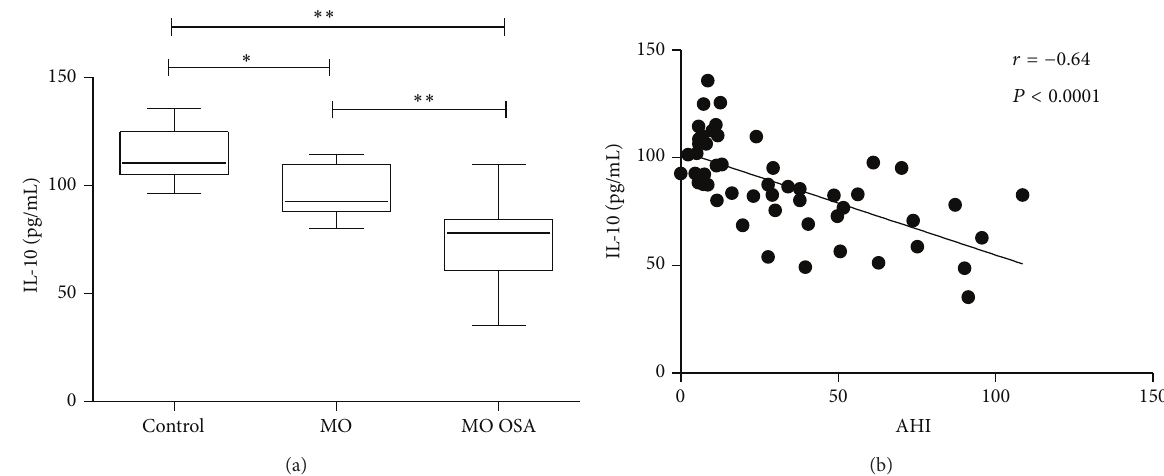
Figure 1: (a) Box plot of circulating IL-10 levels for control, MO, and MO+OSA subjects. Data are expressed as the median and interquartile range in a box plot analysis. (b) Correlation between AHI and IL-10 circulating levels. AHI was negatively correlated with IL-10 levels. Coefficient 𝑟 and 𝑃 valueswerecalculatedbytheSpearman’scorrelationmodel.Thecorrelationlevelwasconsideredsignificantwhen 𝑃 < 0.05 . ∗ 𝑃 < 0.05 and ∗∗ 𝑃 < 0.001 .